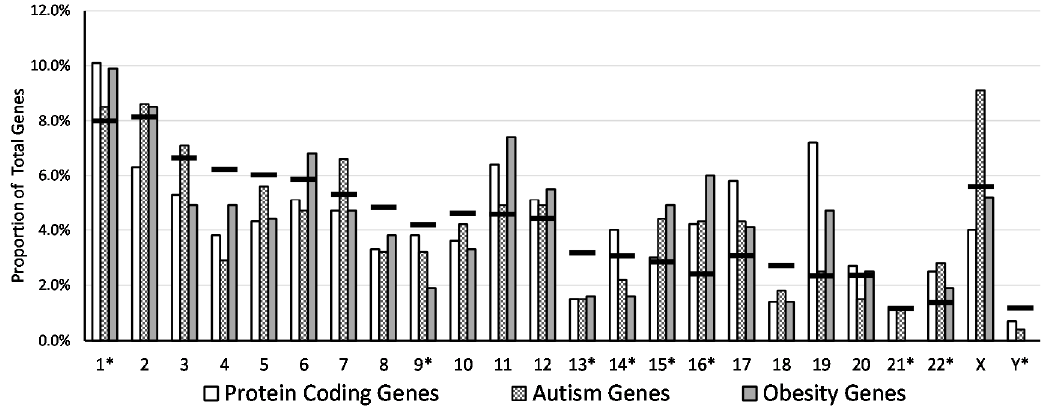
Figure 5. Distribution and proportion of protein-coding, autism and obesity genes by chromosome. * = Length and genes of qh, centromeric and/or acrocentric chromosome p arm regions were excluded. Horizontal black line (—) for each chromosome represents the expected proportion of genes based on chromosome size relative to the total length of all chromosomes summed together.